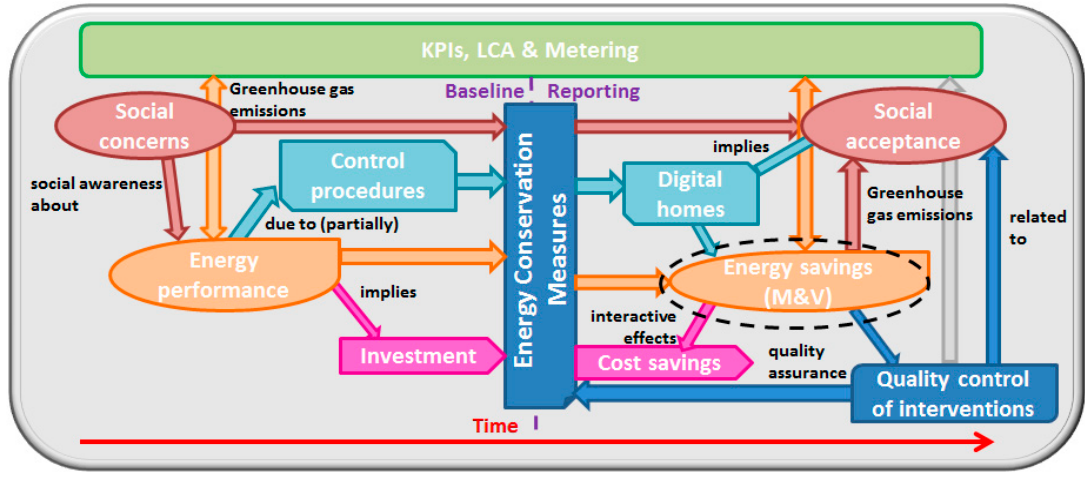
Figure 1. Proposed sustainability evaluation